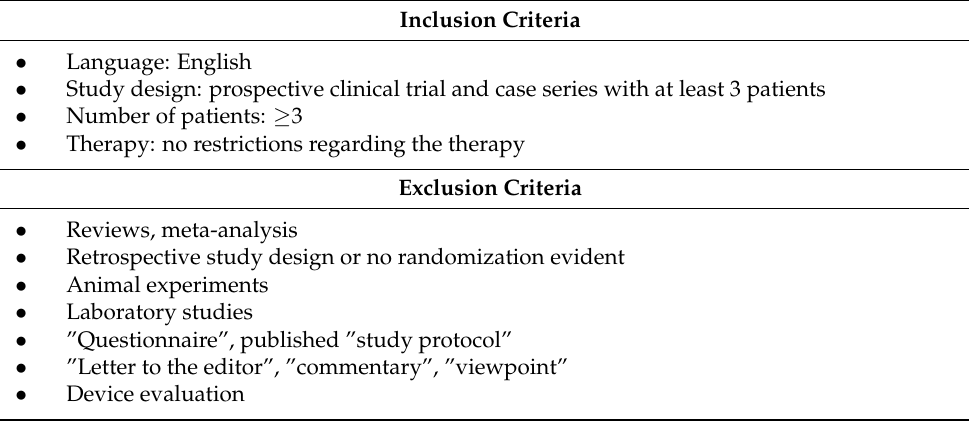
Table 1. Inclusion and exclusion criteria.